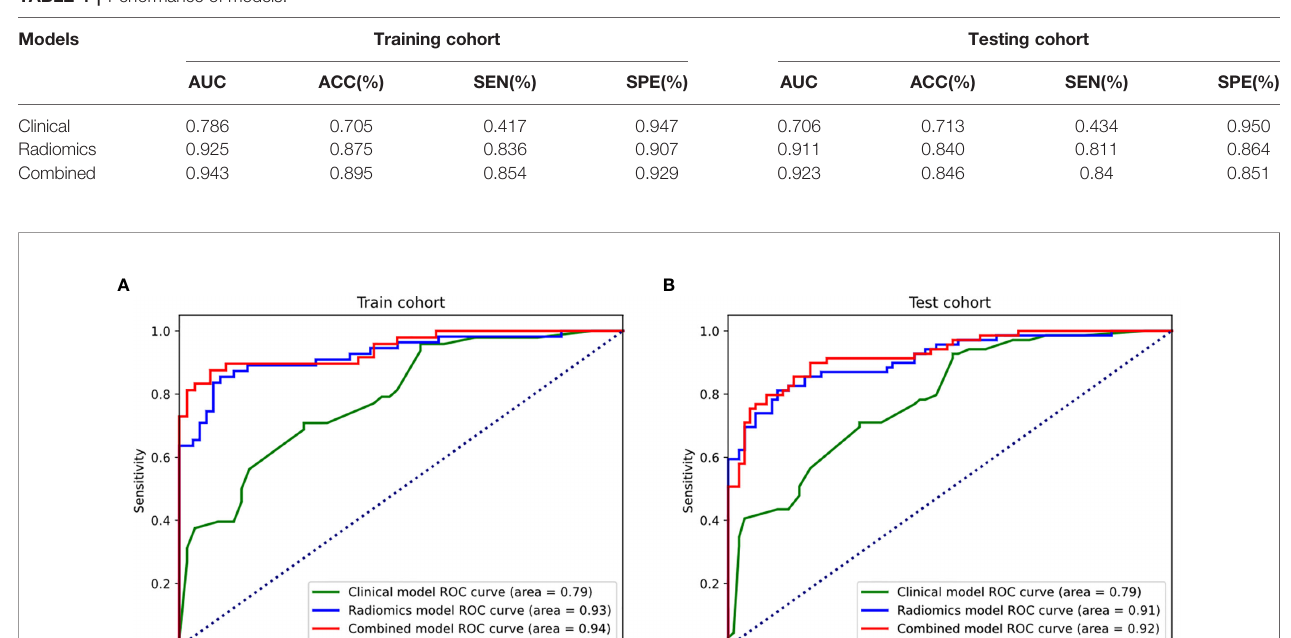
TABLE 4 | Performance of models.